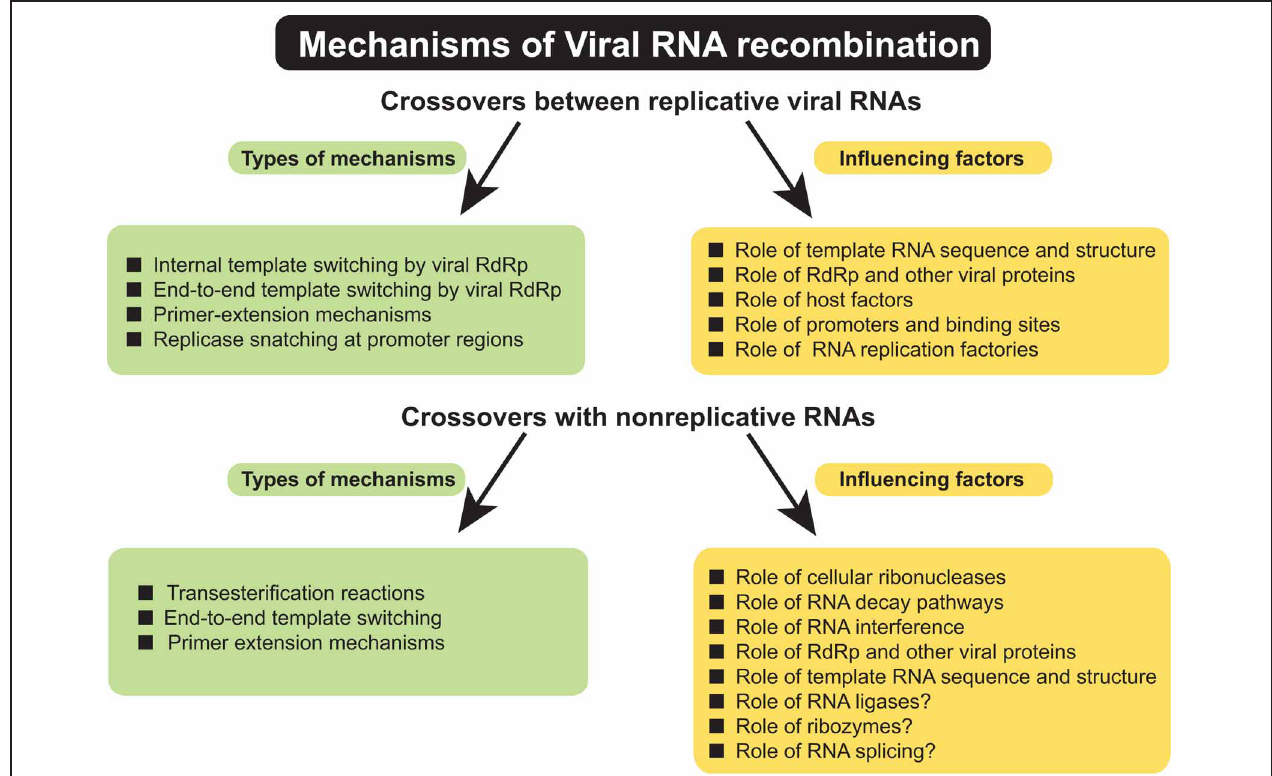
FIGURE 1 | Summary of types of mechanisms of genetic RNA recombination in ( + ) RNA viruses and factors influencing the RNA–RNA